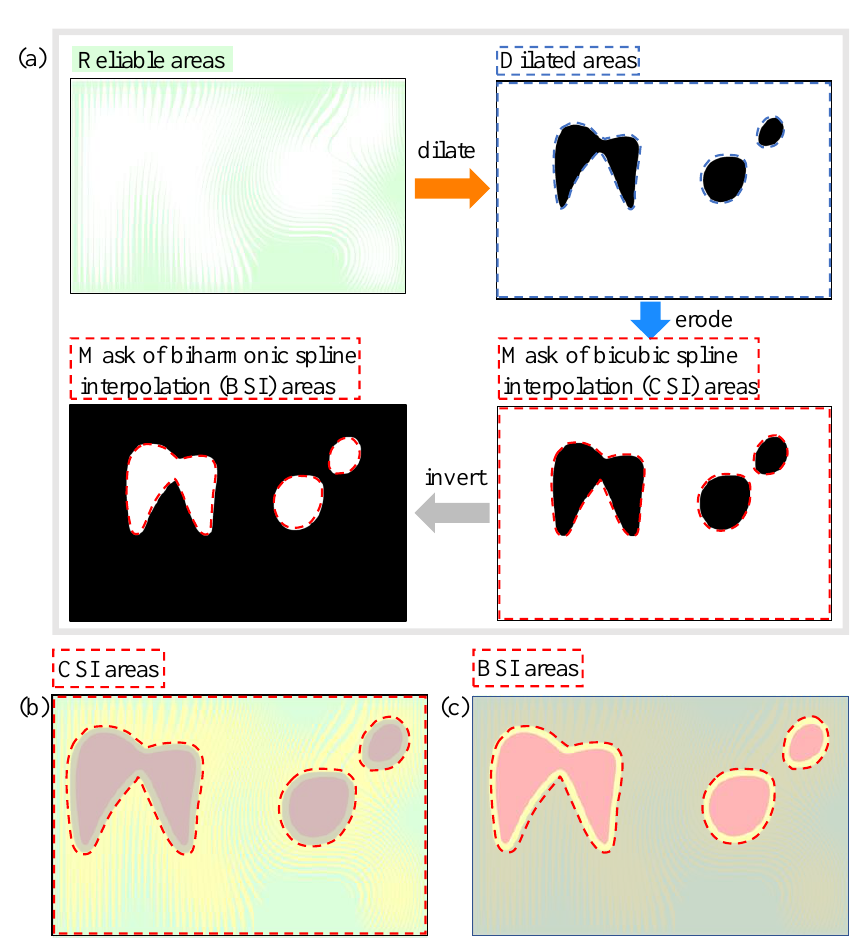
Figure 4. Examples of the formation of cubic spline interpolation (CSI) area and biharmonic spline interpolation (BSI) area. ( a ) Dilation and erosion of the reliable areas to obtain CSI and BSI areas. ( b ) Place the mask of CSI areas on the division map of A . The bright areas surrounded by red dotted lines represent CSI areas. ( c ) Place the mask of BSI areas on the division map of A . The bright areas surrounded by red dotted lines represent BSI areas.